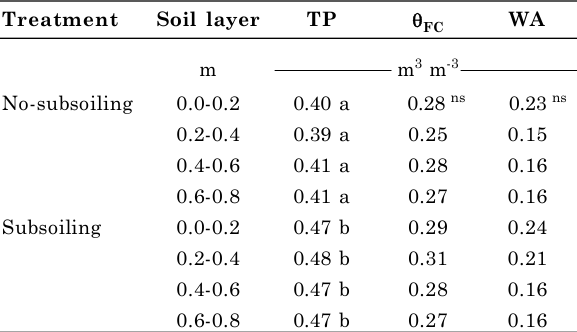
Table 3. Physical and hydric properties of a soil under citrus trees